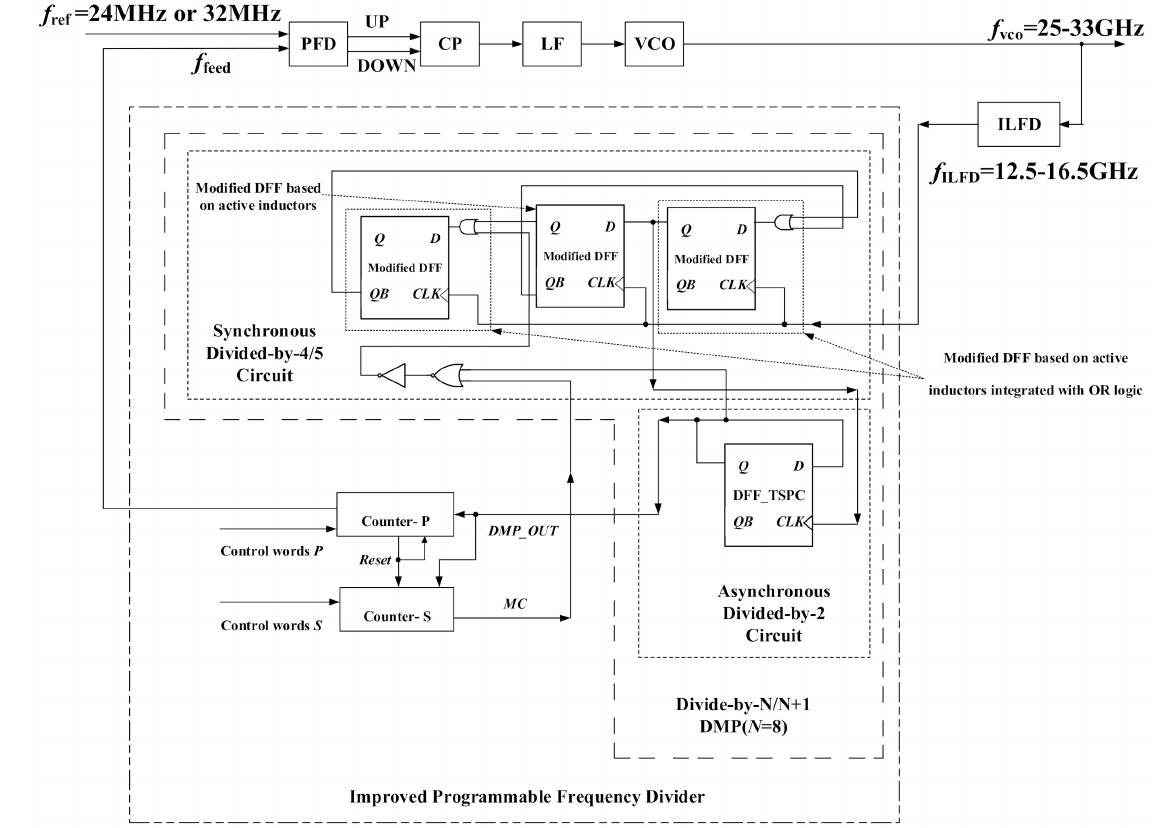
Figure 1. Block diagram of the Ka-band PLL and the improved programmable frequency